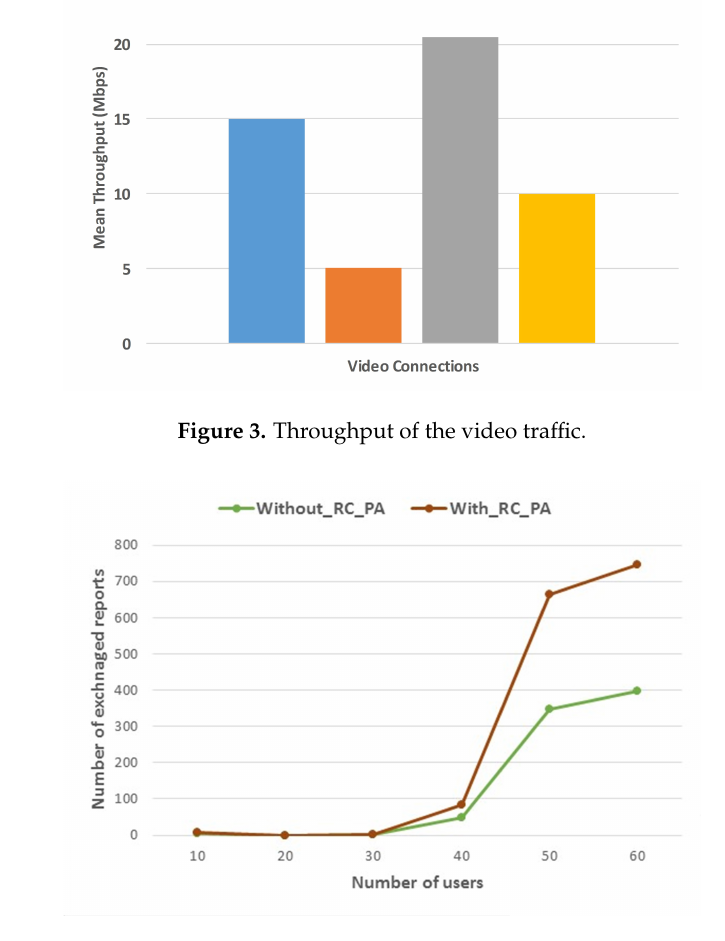
Figure 4. Average number of measurement reports sent by macrocell user equipments and femtocell user